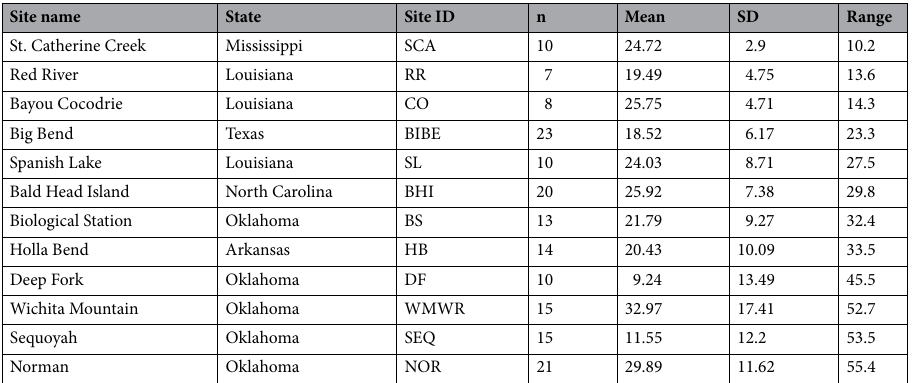
Table 1. Summary table of δ 2 H diff range variation across sites, including sample size (n), mean and standard deviation. At each site, the δ 2 H diff index was calculated by subtracting stable isotope values of hydrogen in feathers (δ 2 H f ) from stable isotope values of hydrogen in precipitation (δ 2 H p ). Smaller δ 2 H diff ranges (close to zero) indicate molting near the sampling location. The largest δ 2 H diff variation is found in the populations of the Central cluster (the last six sites at the bottom of the table from BS to